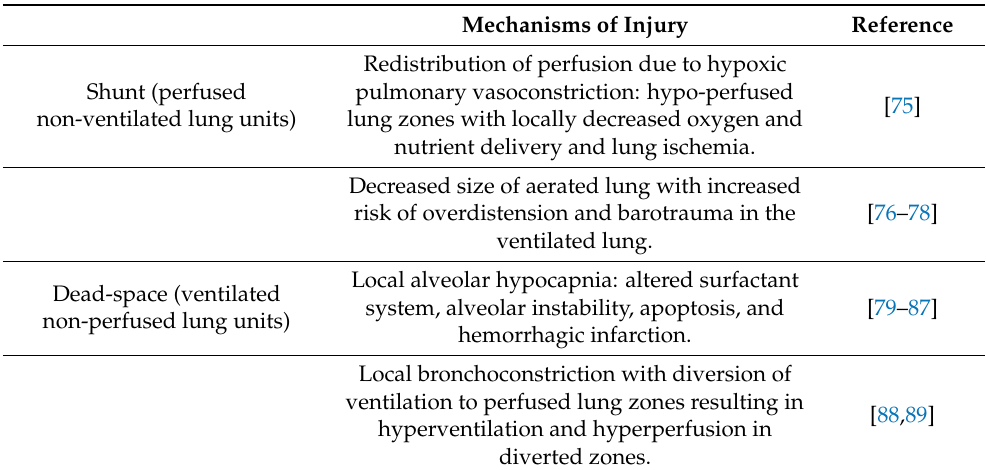
Table 1. V / Q mismatch as a mechanism of lung injury. Mechanisms of Injury